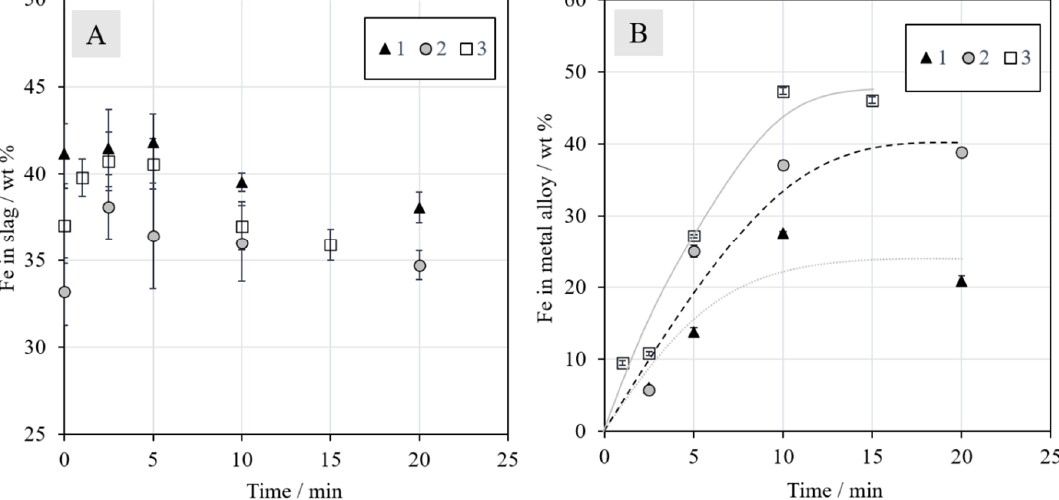
Figure 6. Fe/SiO 2 ratios in the slag as a function of time during reduction with an N 2 + 5% CH 4 mixture.